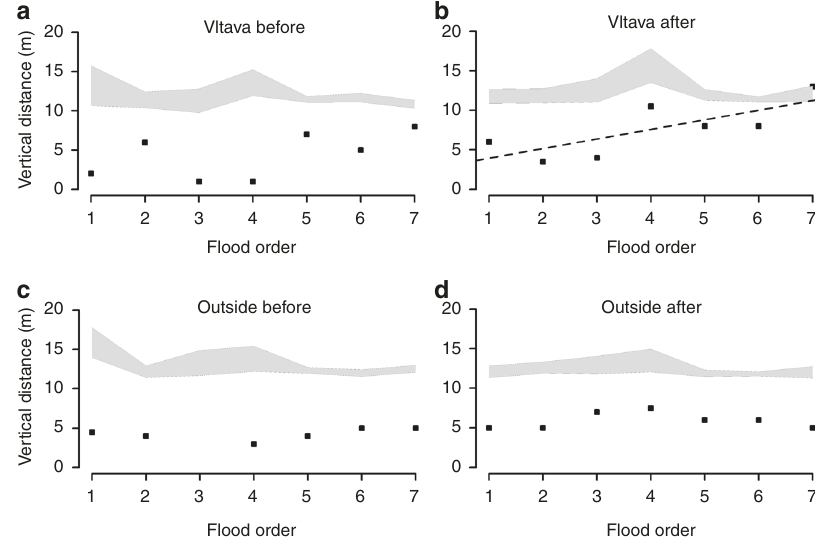
Fig. 1 Median vertical distances to the nearest watercourses throughout 9 centuries. A comparison between the median vertical distances of newly established settlements (black squares) in the four situations (within and outside the Vltava region up to 25 years before and up to 50 years after fl ood disasters) and the range of randomly generated points (shaded areas) in the same areas and periods shows that people were strongly attracted towards watercourses. A dashed line refers to a statistically signi fi cant trend (see Results). The value before the third fl ood outside the Vltava was 34 m and lies beyond the presented limit. The variance in vertical distances of randomly generated points may be affected by the different sample size used for the simulation (see Methods section and Supplementary Table